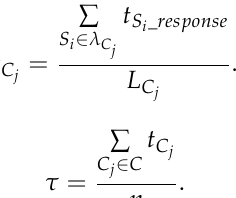
Algorithm 1 first calculates the loads L C